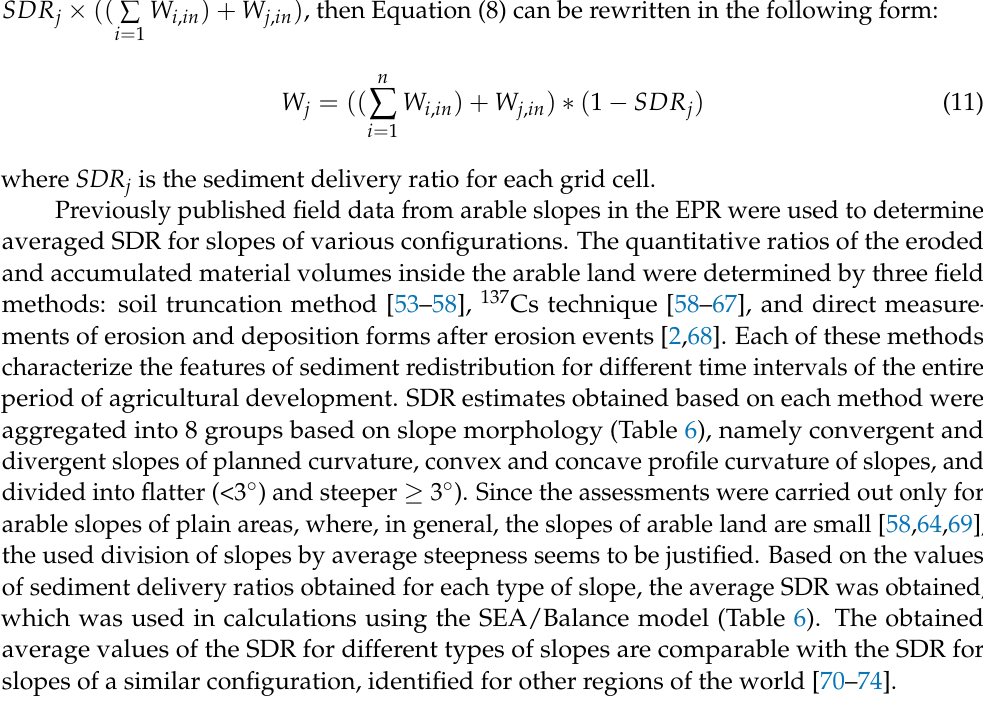
Table 6. Sediment delivery ratio used in calculations of sediment redistribution in arable land. Plan Curvature +(Concave, Convergent) − (Convex, Divergent)